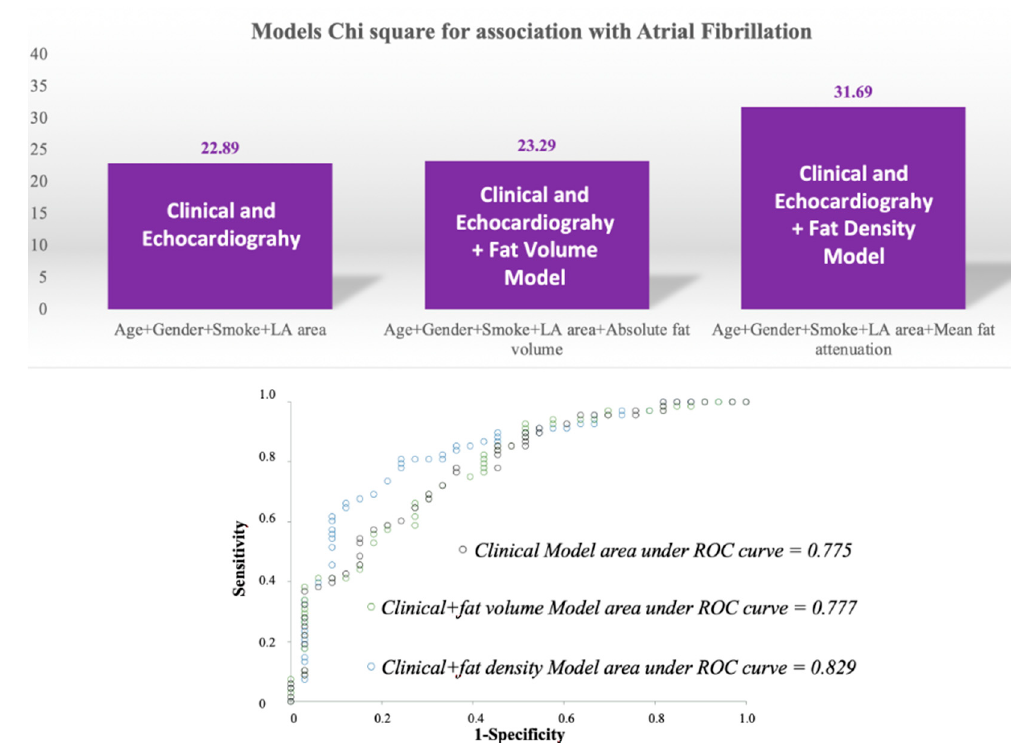
Figure 3. Chi square and area under the ROC curve for the clinical plus echocardiography model compared with the model obtained with the addition of fat volume or fat density variables. LA, left atrium.